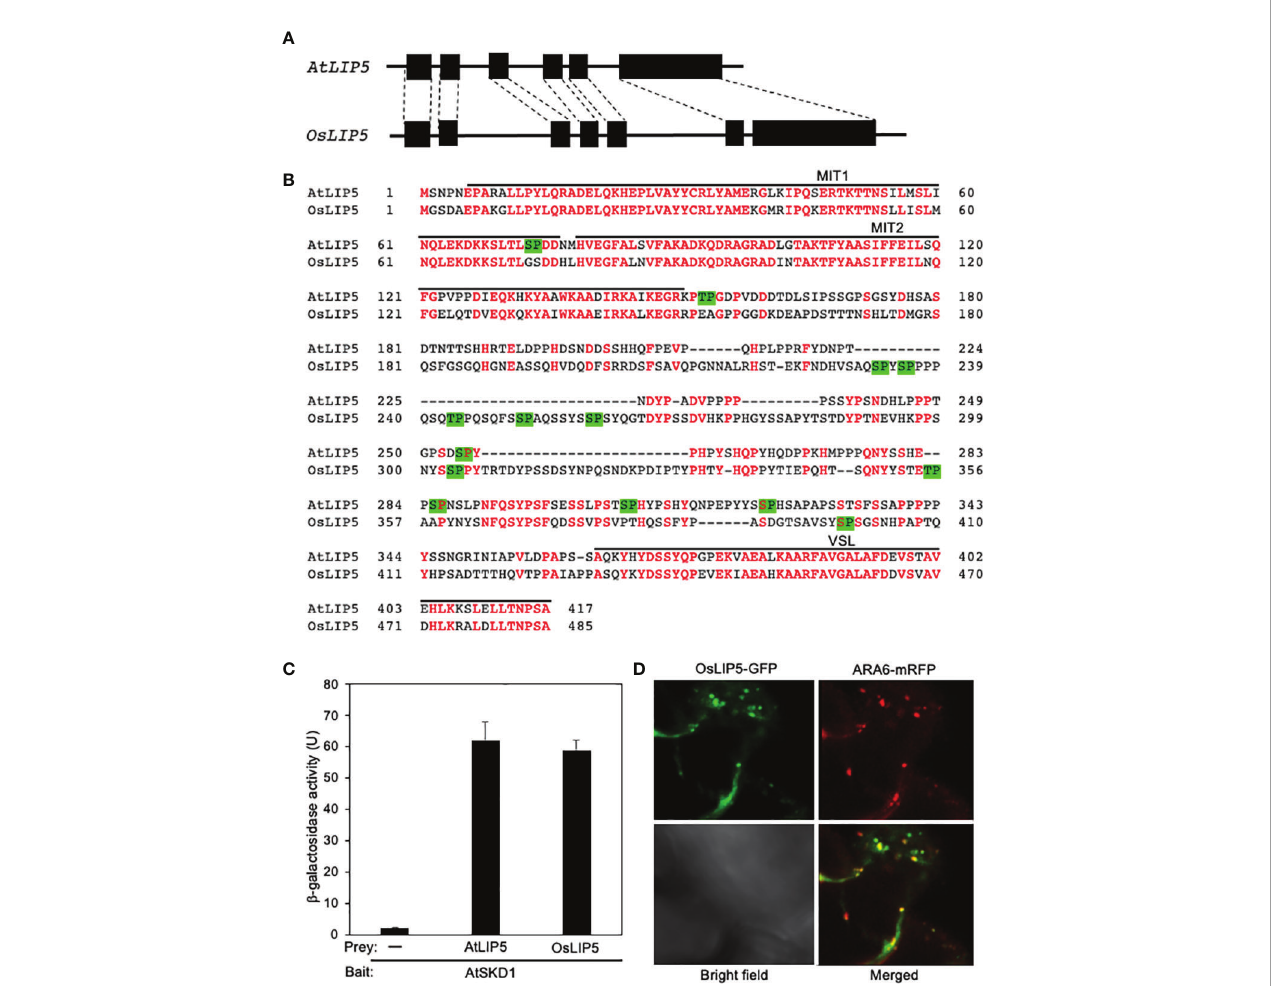
FIGURE 1 Gene structure, protein sequence, interaction with SKD1 and subcellular localization of rice LIP5. (A) Arabidopsis and rice LIP5 gene intron (line) and exon (box) architecture. The homologous exon between the Arabidopsis and rice LIP5 genes are indicated by dashed lines. (B) Amino acid sequence alignment of Arabidopsis and rice LIP5 proteins. Identical amino acid residues are in red. The N-terminal tandem MIT and C-terminal VSL domains are indicated. Putative TP and SP phosphorylation sites by proline-directed protein kinases are in green background. (C) Yeast two-hybrid assays of LIP5 proteins with AtSKD1. The indicated fusion bait and prey constructs were co-transformed into yeast cells. Empty pAD-Gal4 vector was used as negative control (-). Yeast transformants were analyzed for LacZ reporter gene expression through assays of b -galactosidase activity using ONPG (o-nitrophenyl- b -D-galactopyranose) as substrate. Data of arbitrary units (U) represent means and standard errors (n=5). (D) Subcellular colocalization of OsLIP5-GFP with ARA6-mRFP when co-expressed with AtSKD1 in the leaf epidermal cells of N. benthamiana